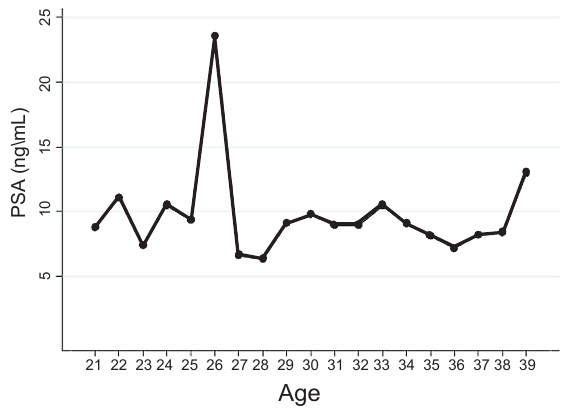
Figure 7 - Separate analysis of those with PSA > 4.0